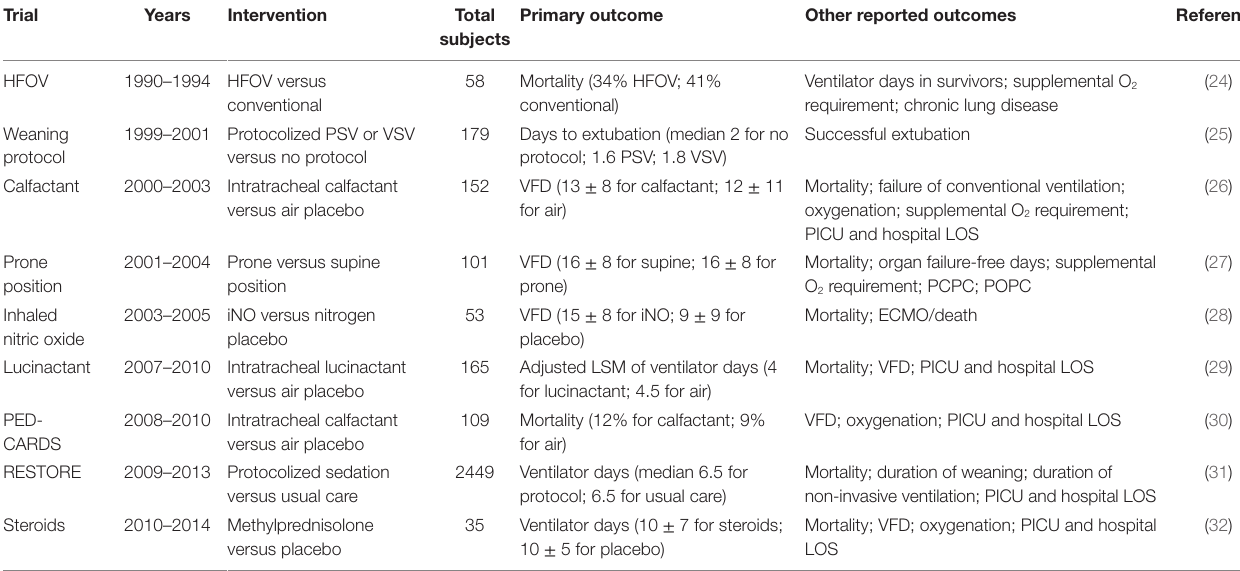
TABLe 2 | Reported outcomes in select placebo-controlled randomized clinical trials in acute respiratory failure and